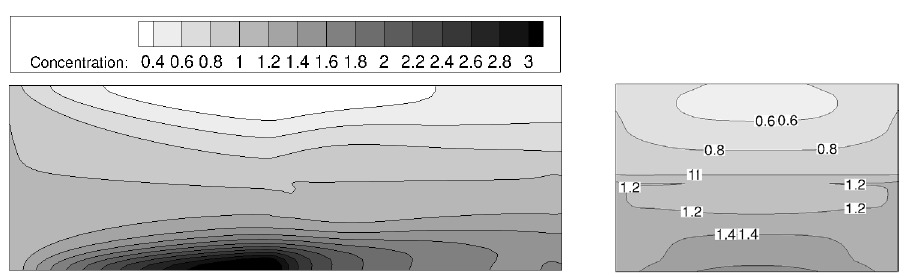
Figure 3. Distribution of the impurity concentration at the Z = 1 . 5 plane (left) and at the X = 6 plane